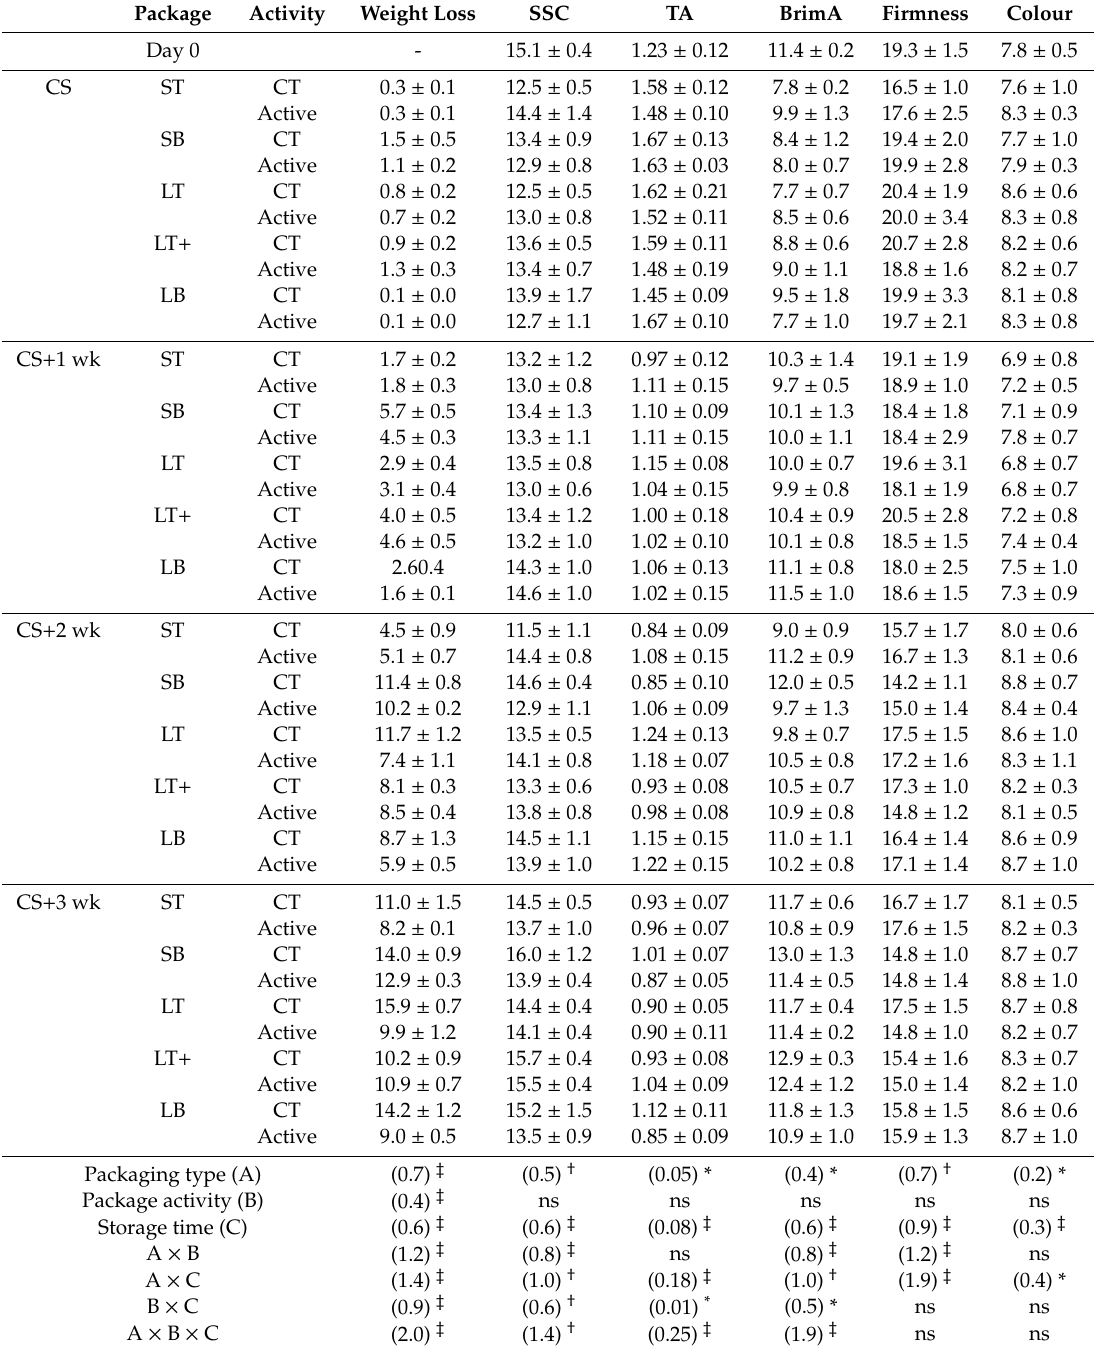
Table 1. Weight loss (%), soluble solid content (SSC; ◦ Brix), titratable acidity (TA; %), BrimA maturity index (SSC-(3 × TA)), firmness (N) and colour index of mandarins packaged within di ff erent packages types (ST, small tray; SB, small box; LT, large tray; LT + , large tray with alveoli tray; and LB, large box), non-active (CT) and active, during a cold storage period (CS; 5 days at 8 ◦ C) followed by a commercialization simulation (room temperature) up to 3 weeks (CS + 1 wk, CS + 2 wk and CS + 3 wk) (n = 3 ± SD). Least significant di ff erences are represented between